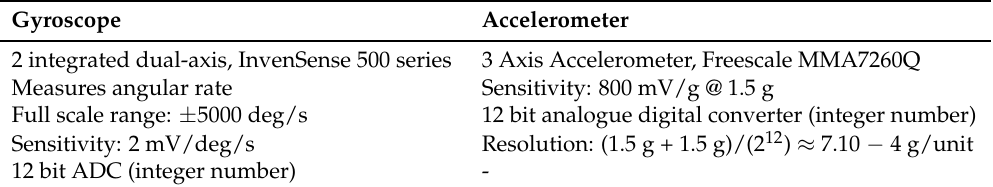
Table 1. The parameter values of the Gyroscope and Accelerometer sensors.